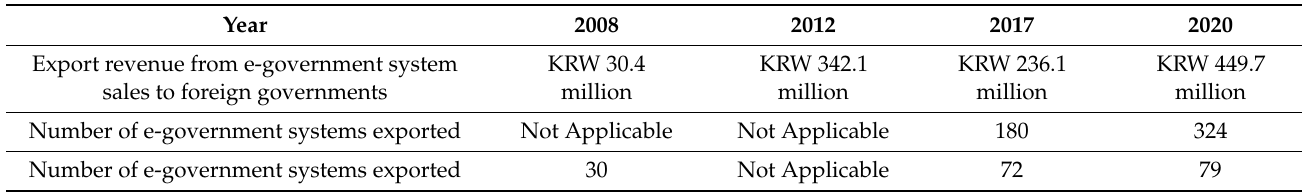
Table 2. Exports of Korean e-government systems to foreign